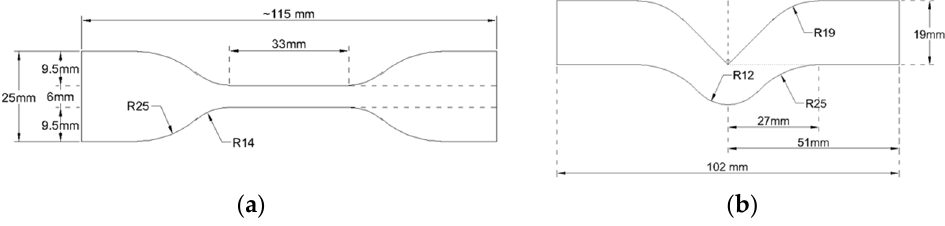
Figure 2. ( a ) ASTM D412 die C sample dimension for tensile properties measurements. ( b ) ASTM D624 die C sample dimension for tear strength measurement.